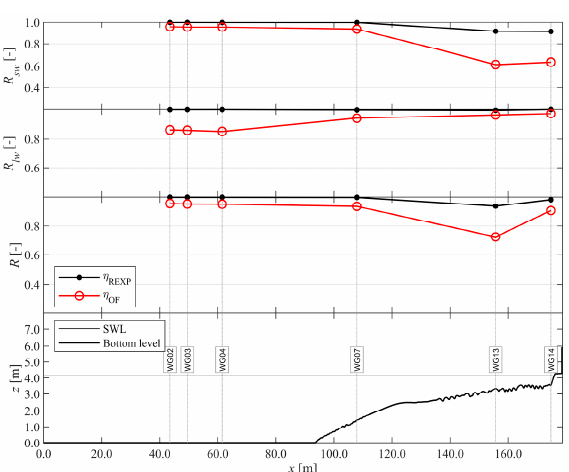
Figure 10. Comparison of R for η of REXP and OF with EXP up to the dike toe. From top to bottom: R sw for η SW , R lw for η LW , R for η , and finally an overview of the sensor locations, SWL , and bottom profile.